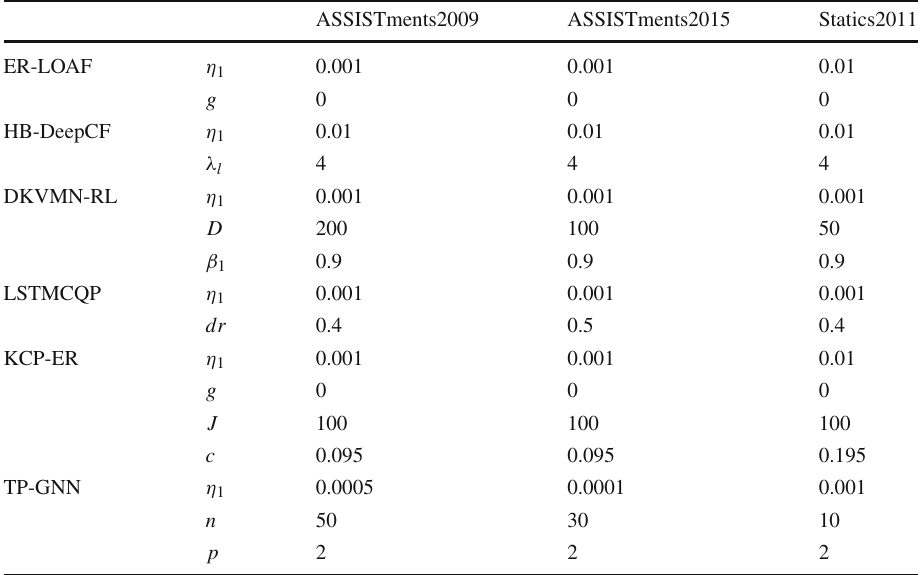
Table 2 Parameter settings for teacher